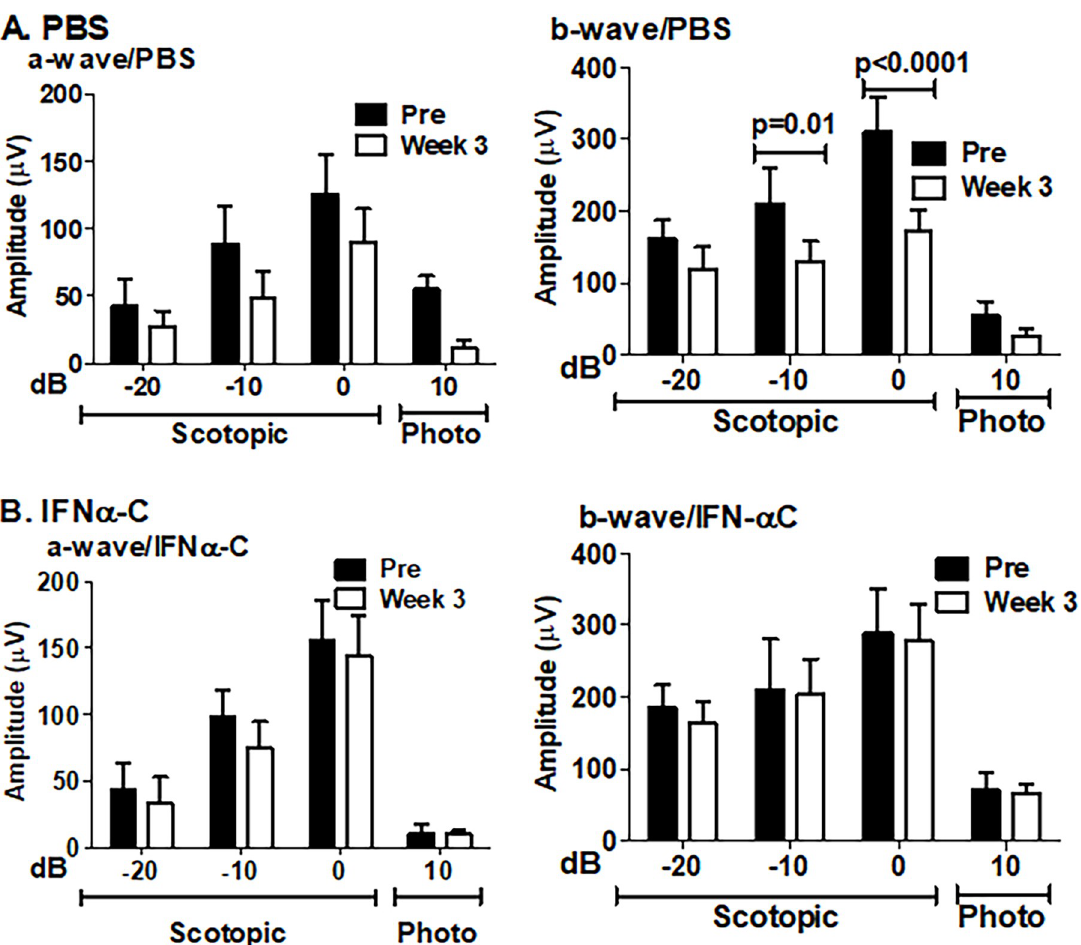
Fig 7. IFN α -C prevented the loss of ERG a- and b- wave amplitudes in EAU mice. Dark adapted and light adapted electroretinograms were recorded in B10.RIII mice before immunization (pre) and 3 weeks after immunization with IRBP and treatment with solvent (top row) or IFN α -C (bottom row). Average a-wave and b-wave amplitudes are shown. The error bars represent standard deviation. The same cohort of mice were used for all data points. P values were determined by 2-way ANOVA using the Sidak method for multiple comparisons. N =